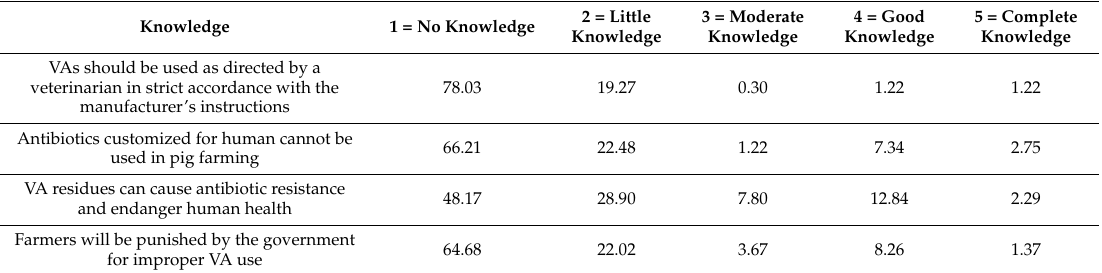
Table 3. Farmers’ knowledge about VAs (in